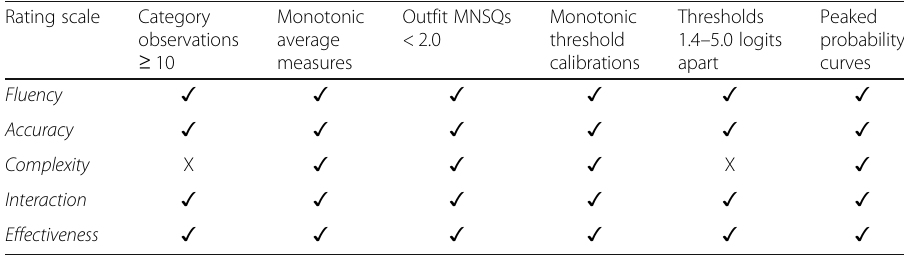
Table 6 Summary of adherence to Linacre ’ s (2002a) guidelines for the 5-point rating scales Rating